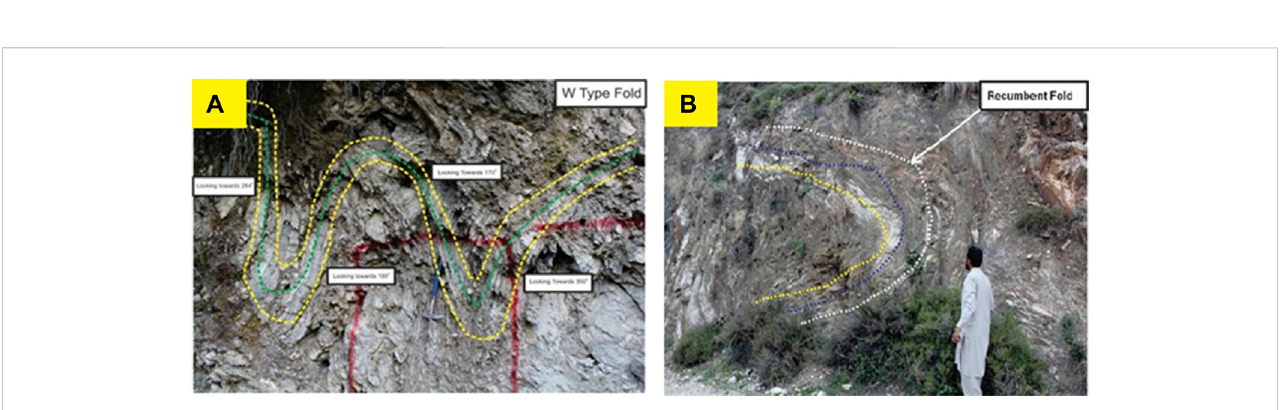
FIGURE 8 (A) Isoclinal-type fold. (B) Recumbent fold.